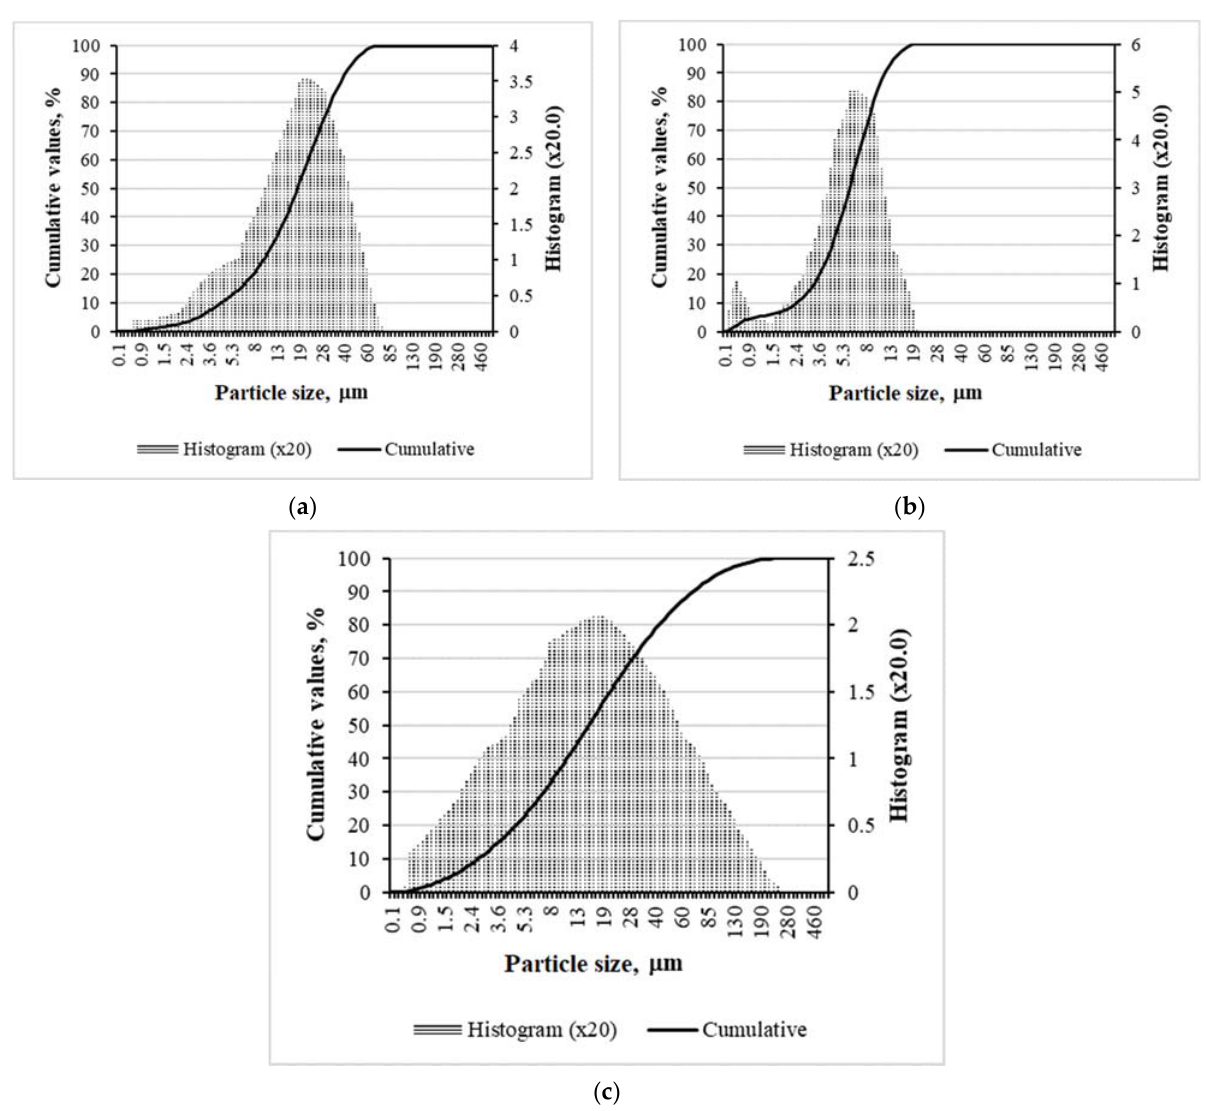
Figure 1. The particle size distributions of: ( a ) OPC; ( b ) silica fume; and ( c ) ground glass. Table 3. The physical and mechanical properties of lightweight